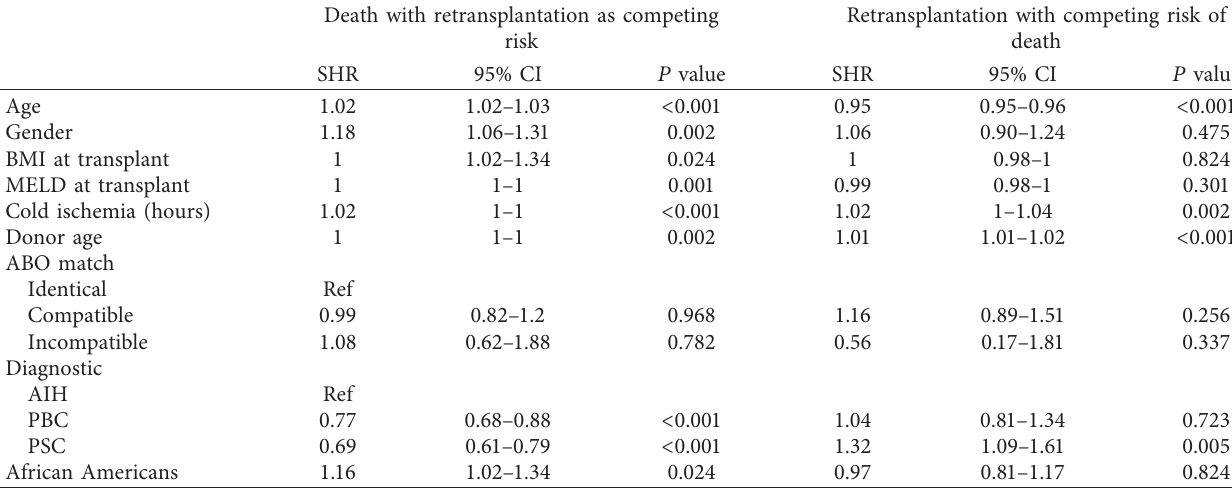
Table 5: Multivariate competing risk analysis for graft survival.